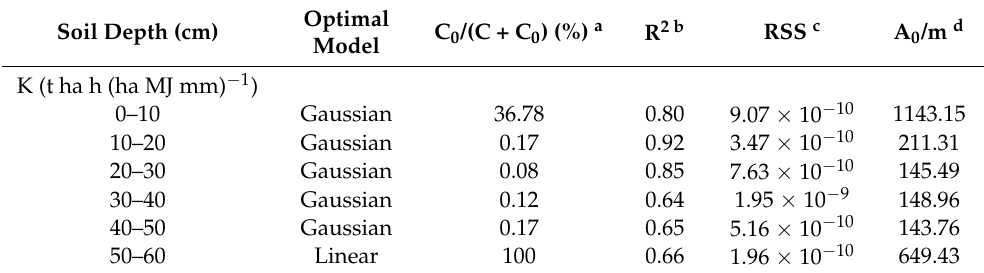
Table 2. Parameters for the semivariogram analyses of the K factor and Ks in different soil